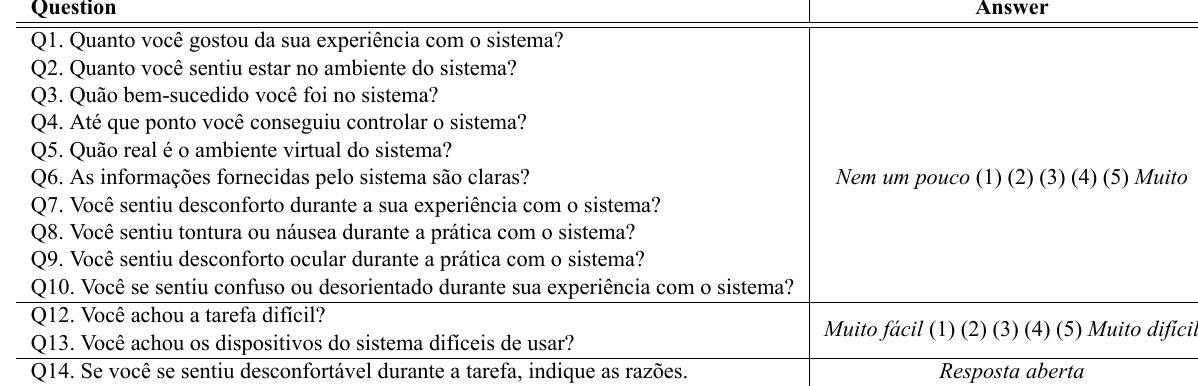
Table 4. Suitability Evaluation Questionnaire adapted and translated into Brazilian Portuguese.